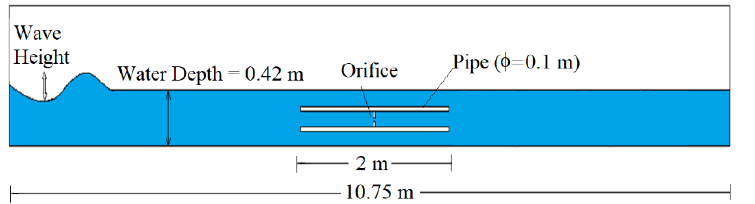
Figure 1. The new concept of wave energy extraction by forcing water flow through a submerged pipe. An orifice plate is used to represent the effects of turbine